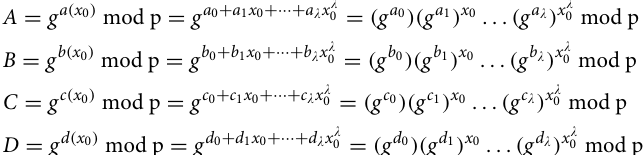
standardized algorithms for key generation, signing and verifying procedures. For key generation, MPPK/DS Xsecure takes about 26 K cycles for all security levels, the fastest algorithm comparing with Dilithium, Falcon, and SPHING+. The second fastest algorithm in key generation is Dilithium, then third is Falcon, and the slowest is SPHINCS+ which is four orders of magnitude slower than MPPK/DS Xsecure. For signing, the relative per- formance is the similar to the key generation procedure, MPPK/DS is the fastest and SPHINCS+ is the slowest, again four orders of magnitude slower than MPPK/DS. It is cearly seen from Table 5 that MPPK/DS signature verification is 4 –6 faster than Dilithium, 10 faster than Falcon, and about 40 faster than SPHINCS+. × × × ×